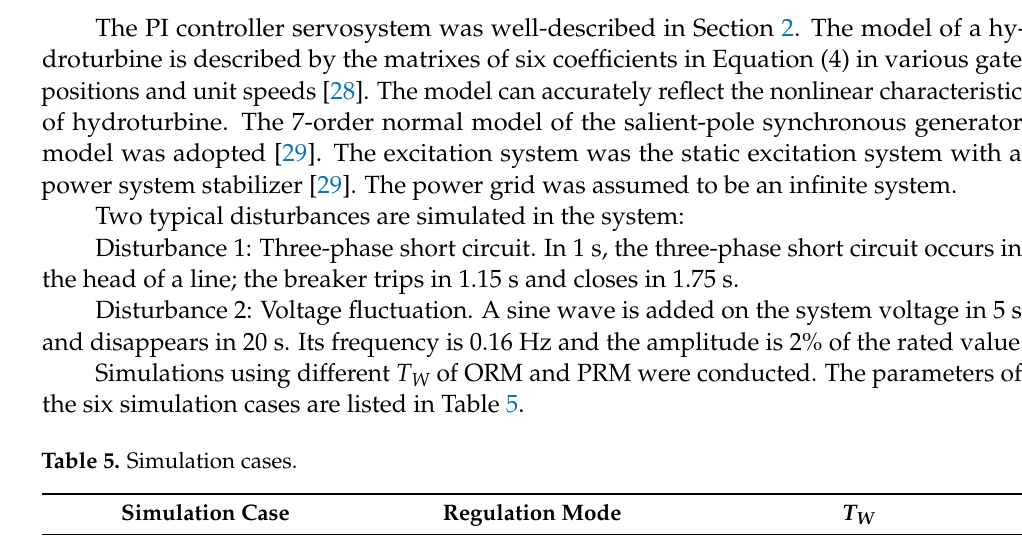
Figure 7. Block diagram of the simulation system.